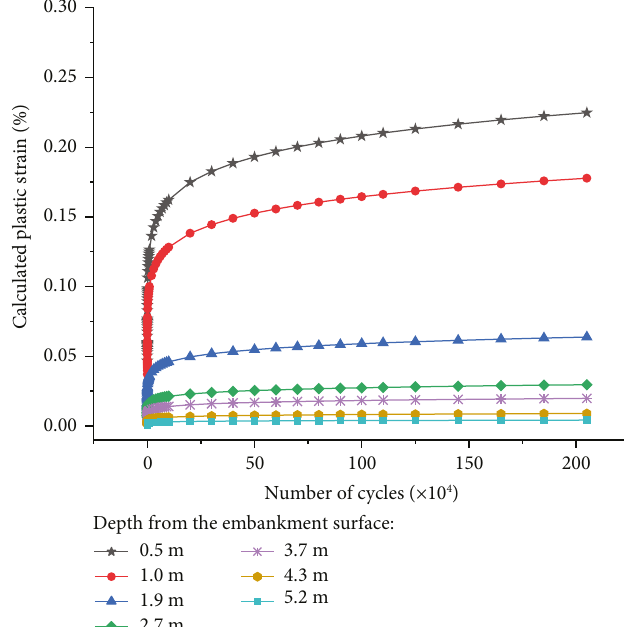
Figure 10: Calculated accumulative plastic strain along the depth.